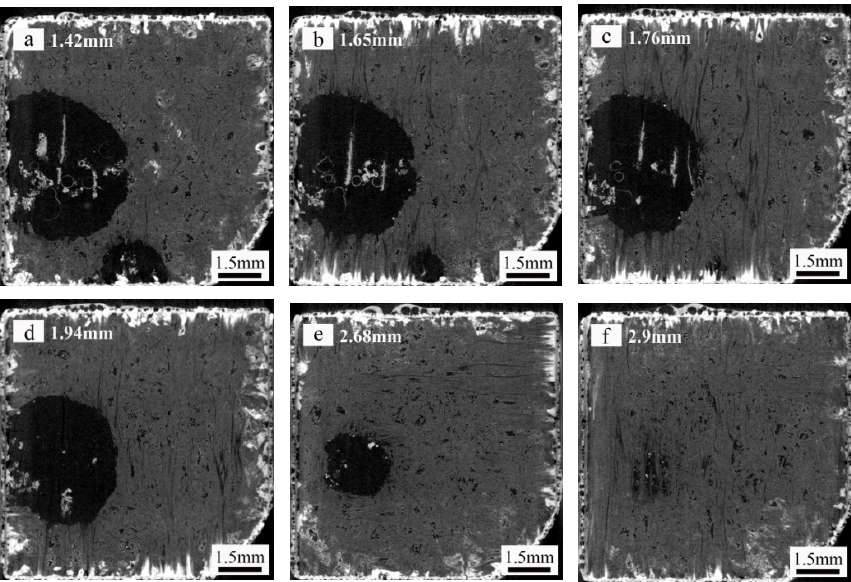
Figure 8. Virtual tomographic slices for the coating specimen of the Figure 7a. ( a ) 1.42 mm; ( b ) 1.65 mm; ( c ) 1.76 mm; ( d ) 1.94 mm; ( e ) 2.68 mm; ( f ) 2.90 mm.